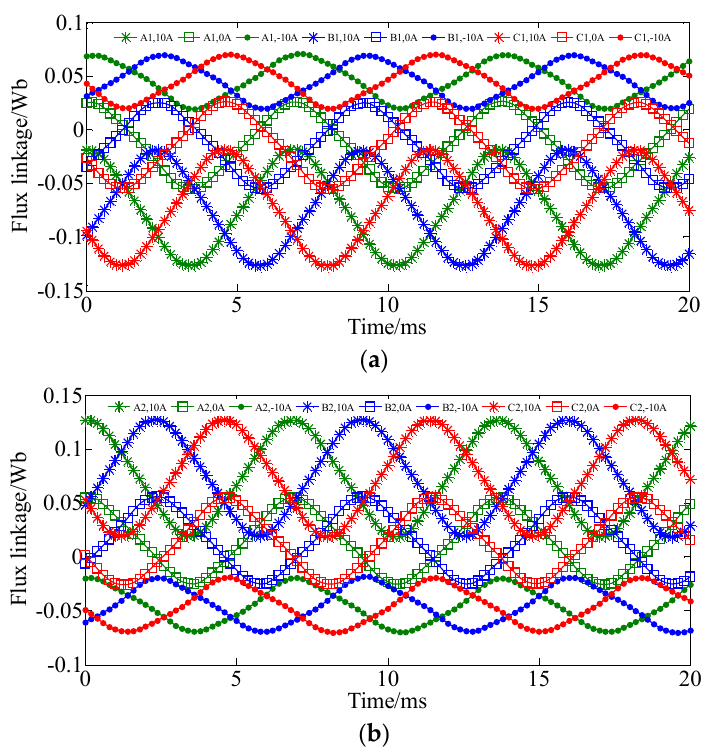
Figure 8. No load flux linkage waveforms. ( a ) Sub-phase one. ( b ) Sub-phase two.